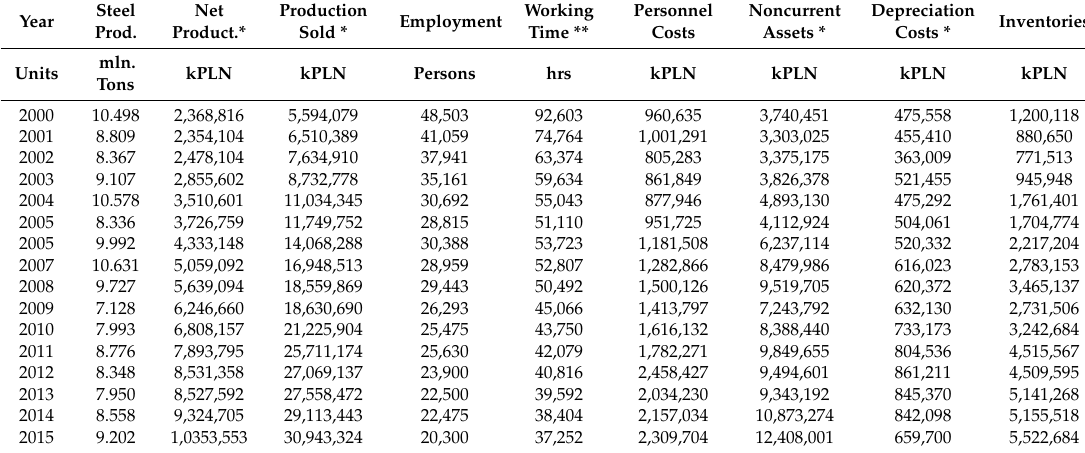
Table 1. Statistical data employed for modelling of production functions in Polish metallurgical sector.